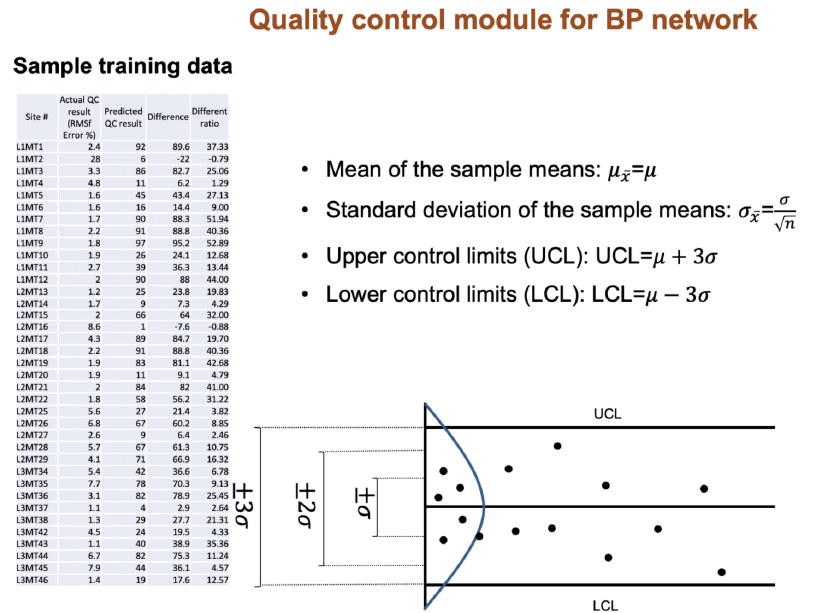
Figure 15. Quality control module for BP artificial network. Create central limit algorithm based on selected sample training data. This model is used to remove outliers of the predicted QA result and feed back to BP artificial network for improvement of training purposes. The table on the left side is 37 selected training data sets. Text and formula in the middle are calculated values of statistical quality control model. Diagram on the bottom explains how this quality control model removes outliers.